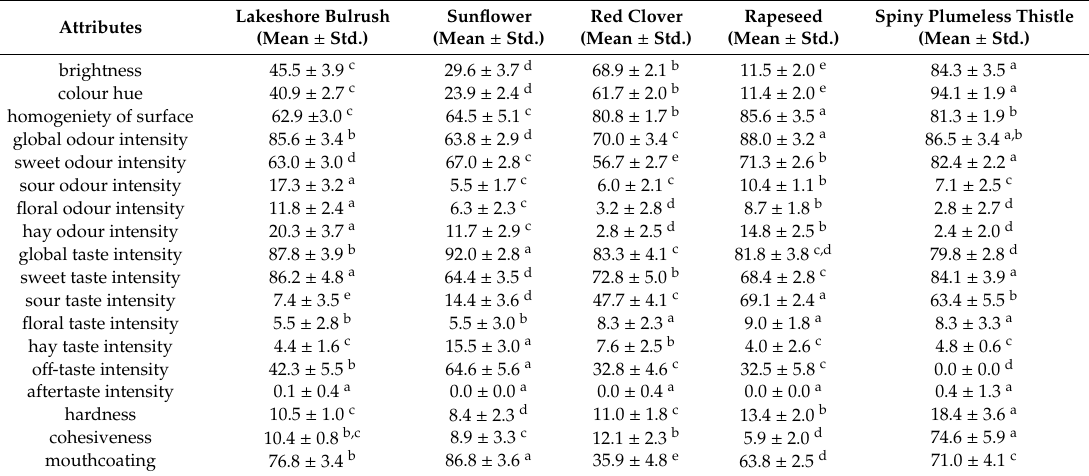
Table 5. Sensory attributes of bee pollen (quantitative descriptive analysis,